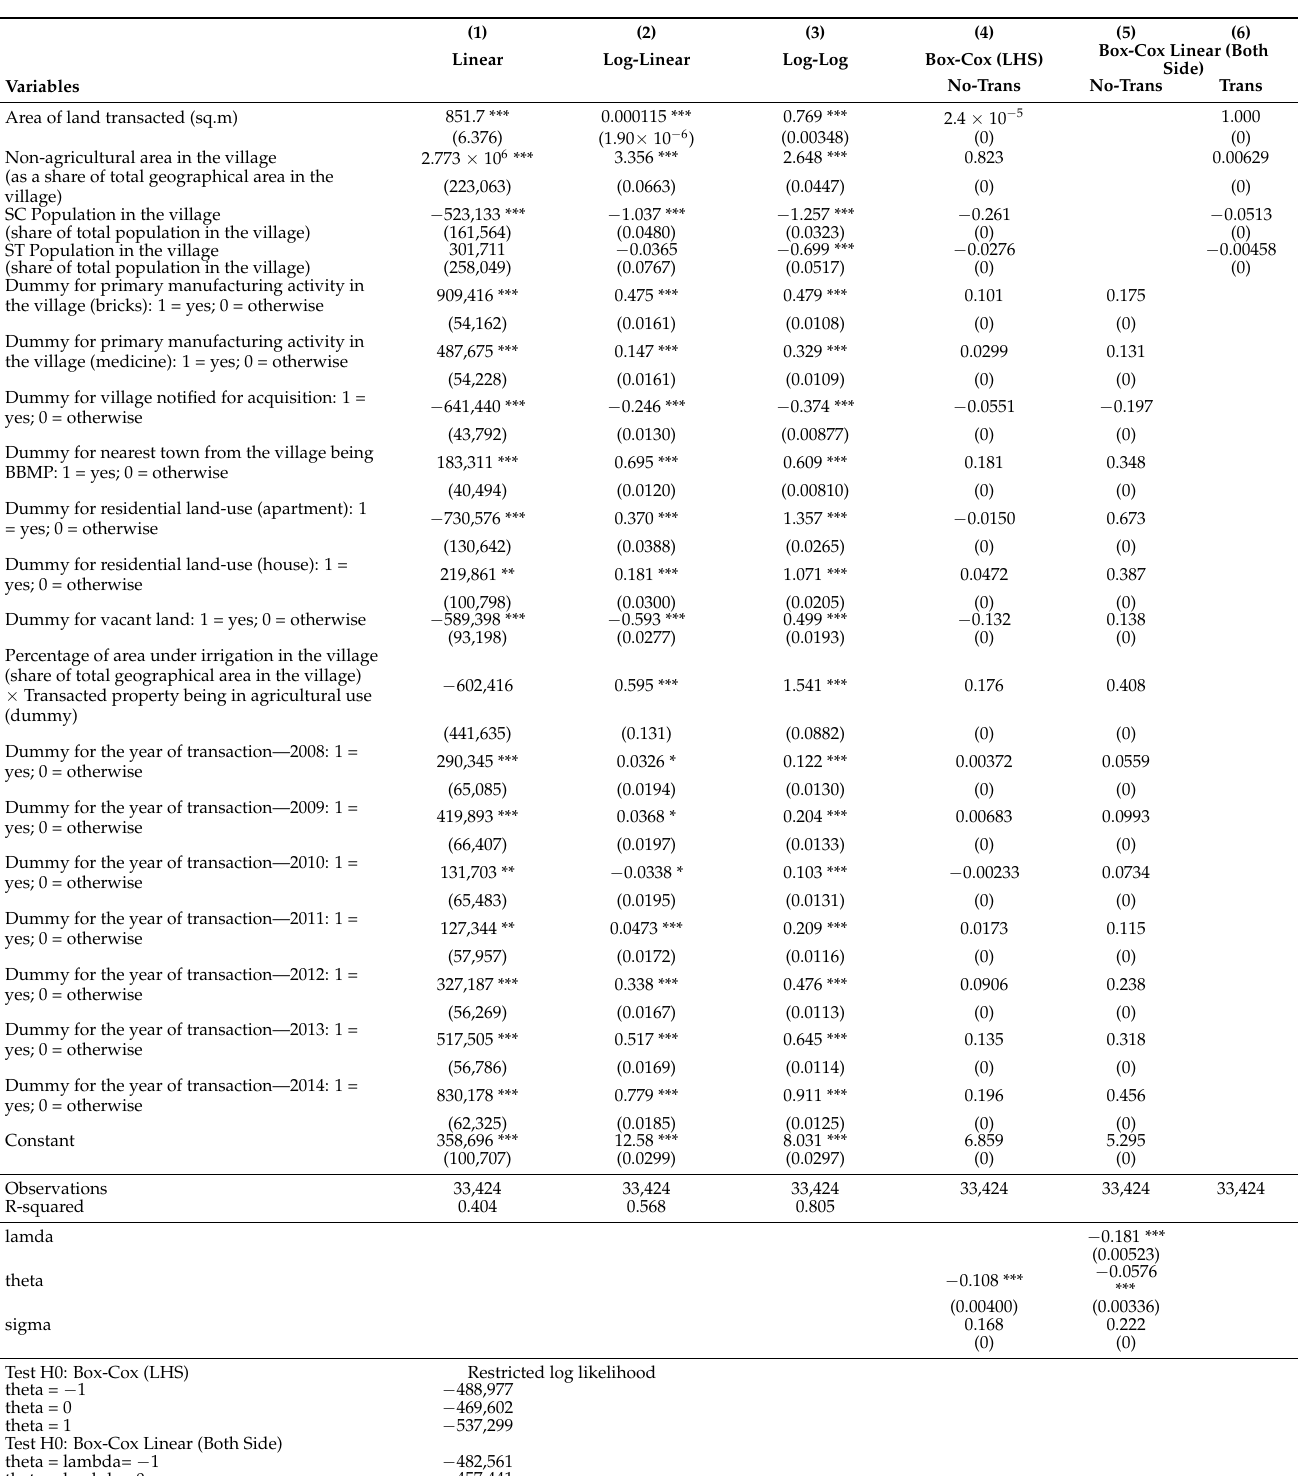
Table 2. Estimation results for alternative hedonic price functions for land value. Standard errors